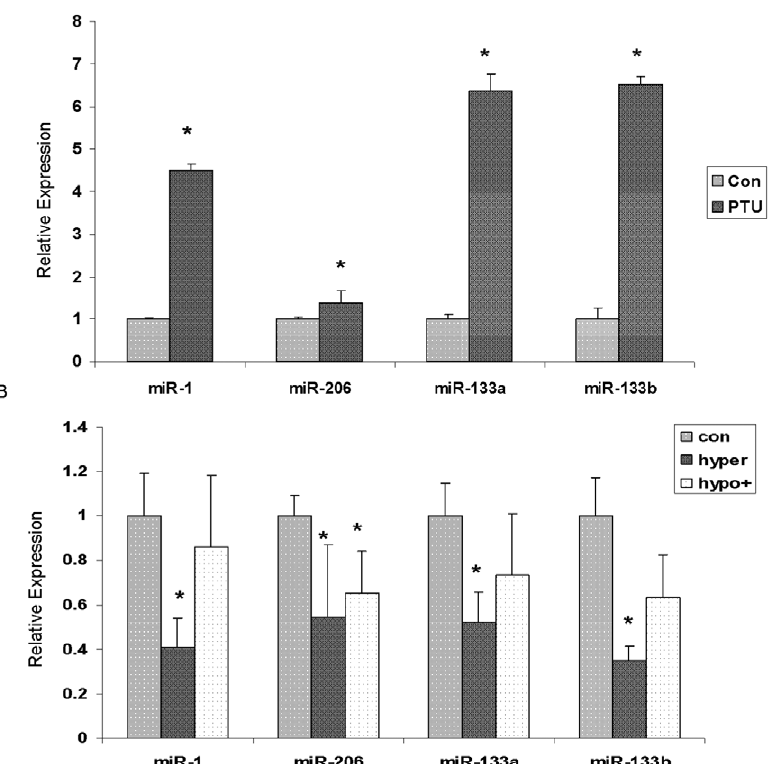
Figure 2. Expression of miRs-1, 206, 133a and 133b in other animal models with altered TH levels. A. Hepatic miRNA expression in livers of PND 15 mouse pups rendered hypothyroid by treatment with drinking water containing 0.04% (wt/vol) of PTU from GD 13 to PND 15. RT-PCR was performed with the Taqman miRNA Assay with RNA derived from male pups (3 per group). B. Hepatic miRNA expression in livers of PND 15 mice whose TH levels were modulated as follows: hyperthyroid pups (hyper) received a s.c. injection of T4 + T3 (50 m g + 5 m g, respectively per 100g bw) four hours prior to sacrifice and corrected hypothyroid pups received drinking water containing MMI and perchlorate (0.05 and 1% wt/vol, respectively) from PND 12 to 15 and an injection of T4 + T3 (20 m g + 2 m g, respectively per 100g bw) four hours prior to sacrifice, while control mice received an injection of PBS only. RT-PCR was performed with the Taqman miRNA Assay with RNA derived from male pups (3 per group). Data are presented as mean 6 SE (n=3). A two-tailed Student’s t-test was used to calculate significance. * indicates p , 0.05.